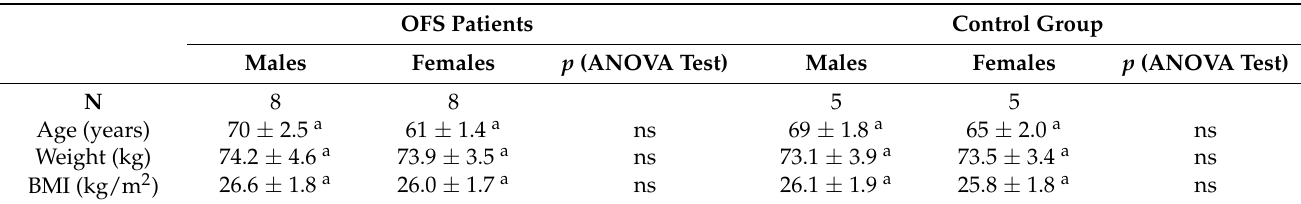
Table 2. Epidemiological findings of study populations (OFS and control groups) and evaluation of the homogeneity divided according to gender. OFS Patients Control